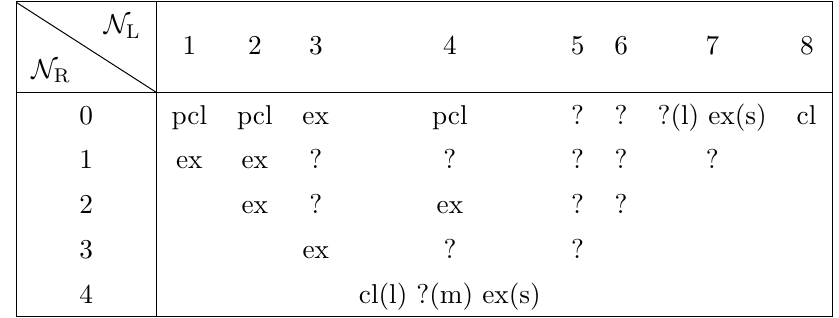
Table 1 . Summary of known AdS 3 classification: “cl” means that a complete classification exists; “pcl” means partial classification; “ex” means that some examples are known; “?” means that no examples are known. As recalled in the text, some cases have a large (l) and small (s) version; N = 4 also has a medium (m) case. In N = 8 the classification exists for all four versions, while for N = 6 and 5 no example is known for either